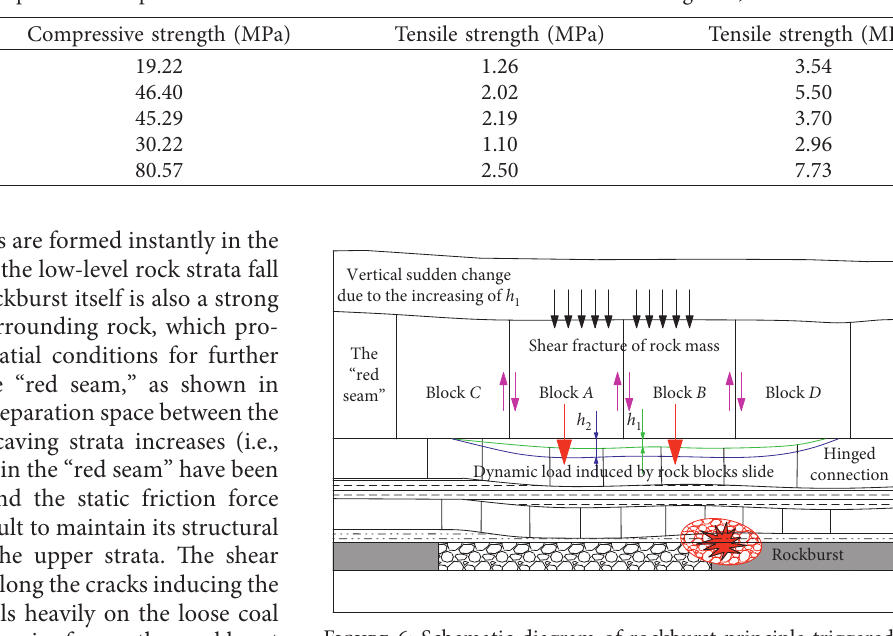
Table 2: Lithologic composition and parameter test results of “red seam” in the Yanzhou mining area, China.